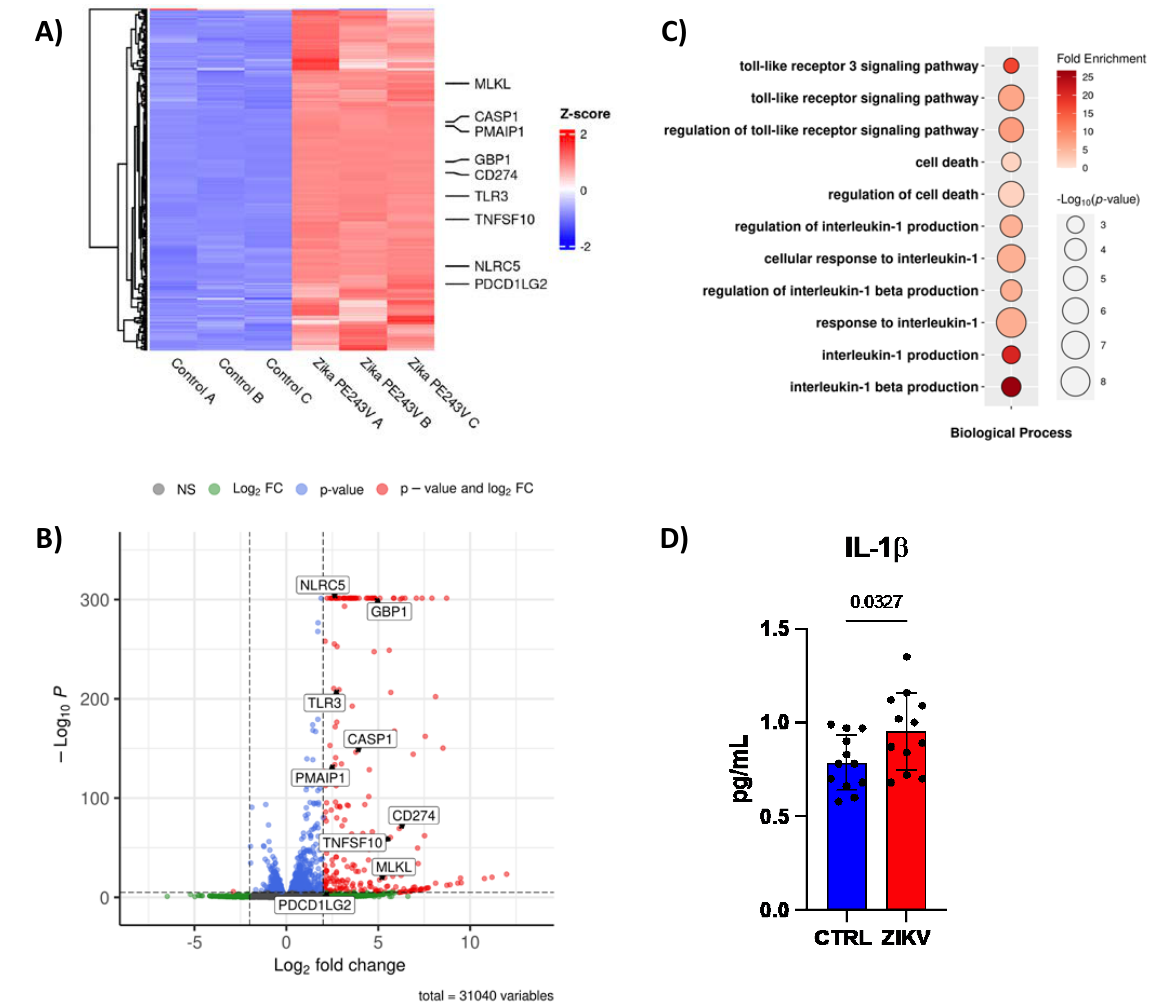
Figure 3. ZIKV downregulates miRNAs increasging cell death. ( A ) Heat-map, ( B ) bubble plot of gene ontology, and ( C ) volcano plot of public RNA-sequencing from hiNPCs (n = 3). 31,040 variables. ( D ) Quantification of IL − 1 β by CBA in supernatant of CTRL or ZIKV infected human NPCs after 48 h post infection (n = 12). Graphs represent three independent experiments. Unpaired t